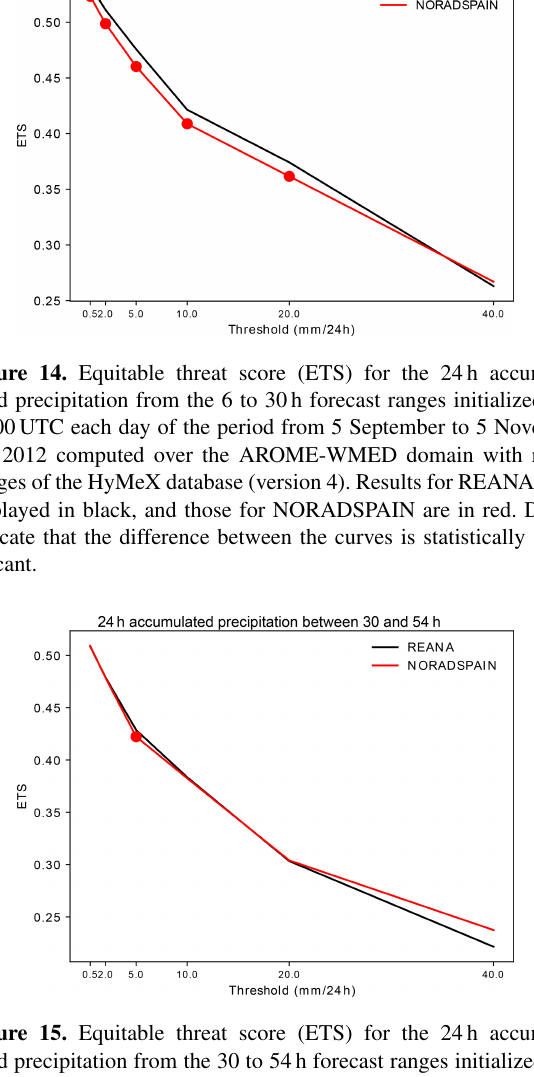
Figure 15. Equitable threat score (ETS) for the 24h accumu- lated precipitation from the 30 to 54h forecast ranges initialized at 00:00UTC each day of the period from 5 September to 5 Novem- ber 2012 computed over the AROME-WMED domain with rain gauges of the HyMeX database (version 4). Results for REANA are displayed in black, and those for NORADSPAIN are in red. Dots indicate that the difference between the curves is statistically sig-